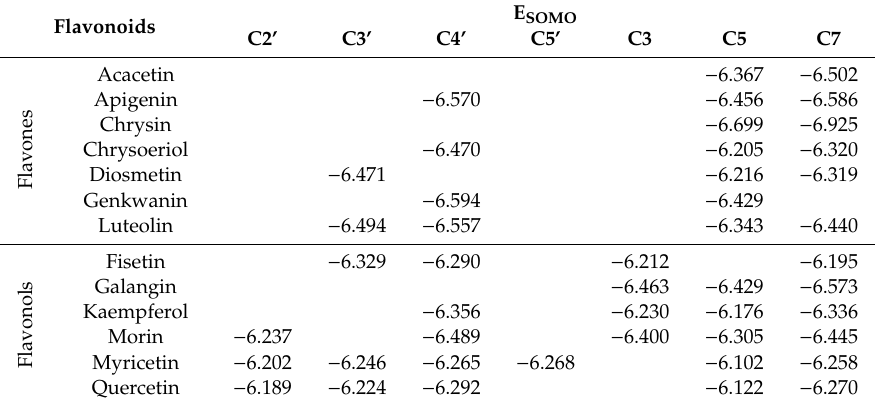
Table A2. Energies of SOMOs of investigated flavonoids’ radicals [eV].